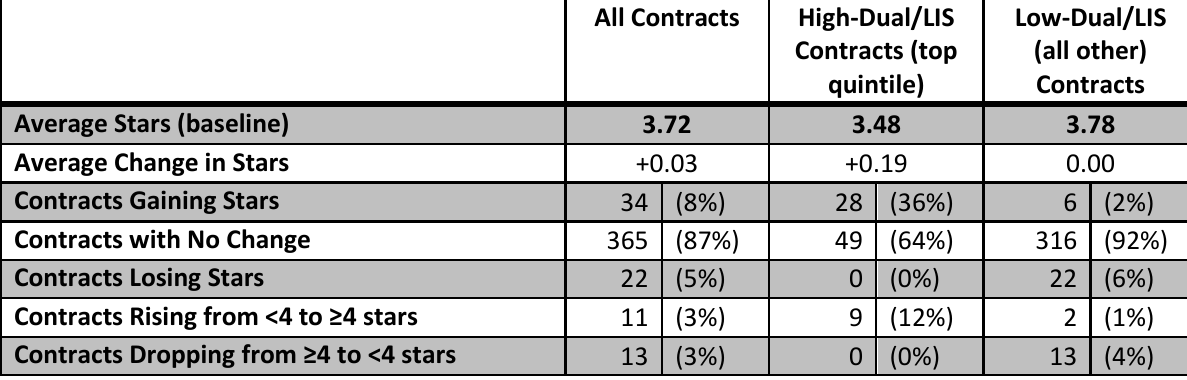
Table 8.13: Adjusting Total Stars Using Population Grouping (via Indirect Standardization) All Contracts High-Dual/LIS Low-Dual/LIS Contracts (top (all other) quintile) Contracts Average Stars (baseline) 3.72 3.78 Average Change in Stars +0.03 +0.19 0.00 Contracts Gaining Stars 34 (8%) Contracts with No Change 365 316 (92%) Contracts Losing Stars 22 (5%) (0%) (6%) Contracts Rising from <4 to ≥4 stars 11 (1%) Contracts Dropping from ≥4 to <4 stars 13 (3%)